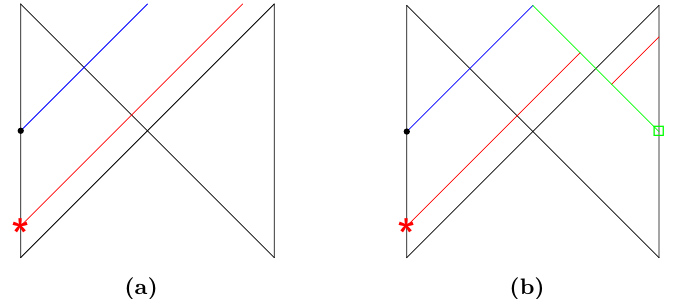
Figure 11. The red line denotes the qubit that is inserted in the left side at time − t . (a) Measurement is implemented at time t = 0 in the left side, and it creates an end-of-the-world brane. The qubit cannot escaped from the horizon to the right side. (b) Measurement is implemented at time t = 0 in the left side, in the mean time, a decoding operator according to the measurement outcome is implemented in the right side. This measurement-decoding protocol can extract the qubit out from horizon to the right side at time t